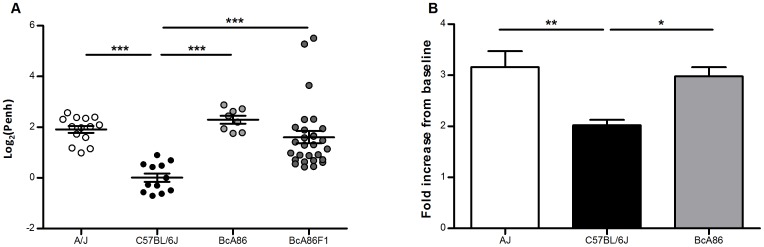
Airway responsiveness phenotype of BcA86 recombinant congenic strain. (A) Enhanced pause (Penh) in response to 15 mg/ml of methacholine was measured in A/J, C57BL/6J, BcA86 and BcA86 F1 mice. (n = 14 A/J, 12 C57BL/6J, 8 BcA86 and 28 BcA86F1). (B) Airway resistance of A/J, C57BL/6J and BcA86 strains in response to 25 mg/ml of methacholine. Resistance values were normalized by baseline readings and data is shown as the fold increase from baseline. Data are presented as mean ± SEM and statistical significance was calculated by one-way ANOVA and Bonferroni correction. n>5 per strain; *, **, and *** represent p<0.05, p<0.01, and p<0.001, respectively.